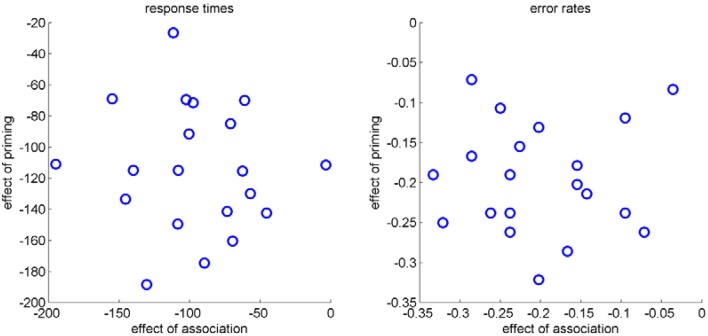
Scatter plots of the effect of association (strong-weak) and the effect of priming (primed-unprimed) for RT (left) and error rates (right) of each participant.